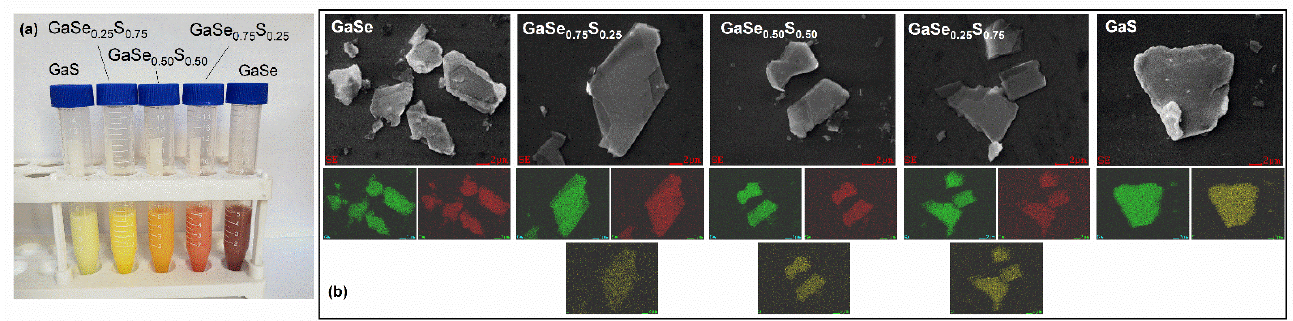
Figure 5. ( a ) Optical images of the GaSe 1-x S x /IPA solutions; ( b ) Results of EDS mapping of the LPE GaSe 1 − x S x